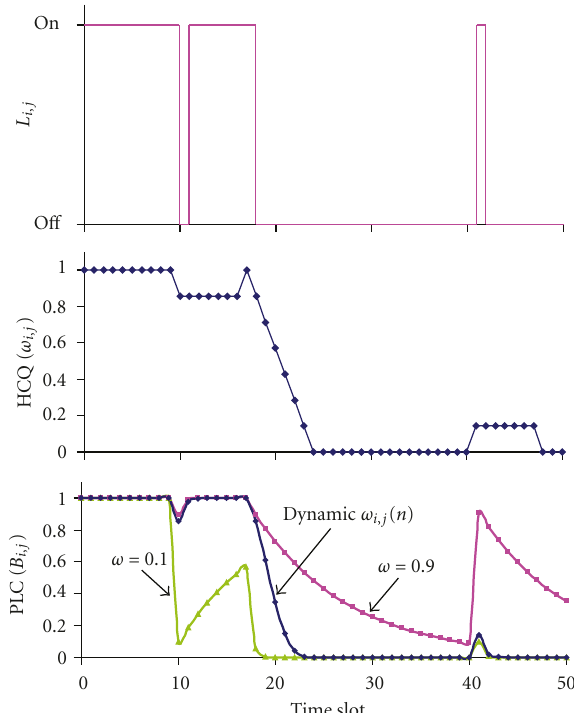
Figure 7: Evolution of multi-scale locality in terms of PLC and